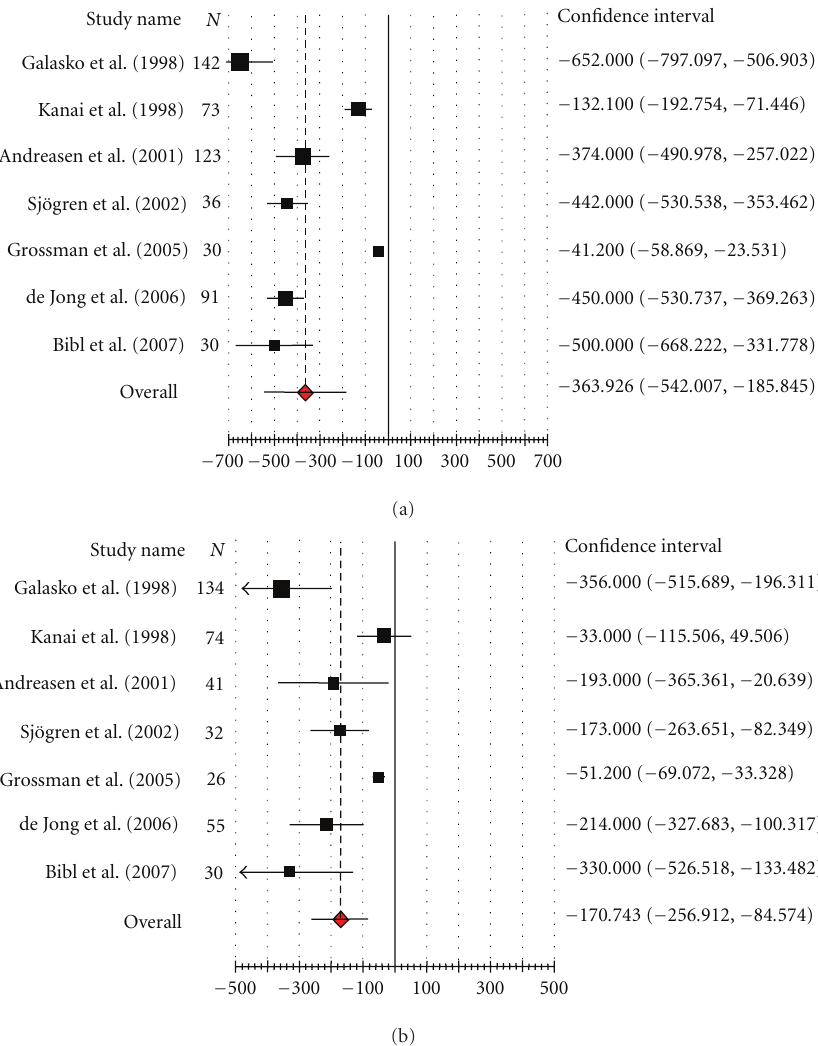
Figure 2: (a) CSF Amyloid β (1–42) level in Alzheimer’s disease. (b) CSF amyloid β (1–42) level in dementia due to other causes.